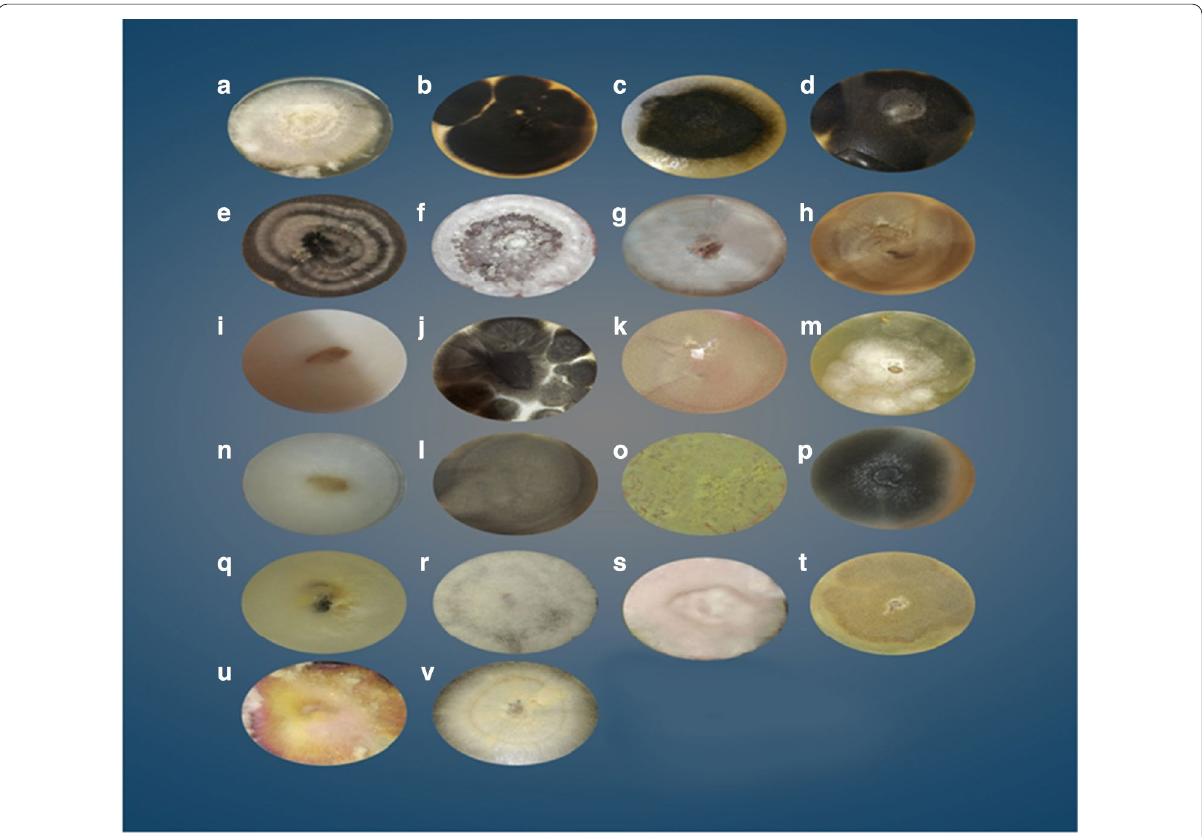
Fig. 3 Fungal isolates from roots and soils from different wheat fields: A. F. verticillioides B. C : a F. verticillioides , b C. oxysporum , c Phoma sp., d . A. alternata , e Bipolaris sp., f F. oxysporum , g A. flavus , h A. terreus , i Mucor sp., j A.niger , k A. fumigatus , l Monilia sp., m R. stolonifer , n A. oryzae , o A. sojae , p A. parasiticus , q Penicillium sp., r F. monilifome , s F. avenaceum , t Pacilomyces sp., u F. roseum , v F.